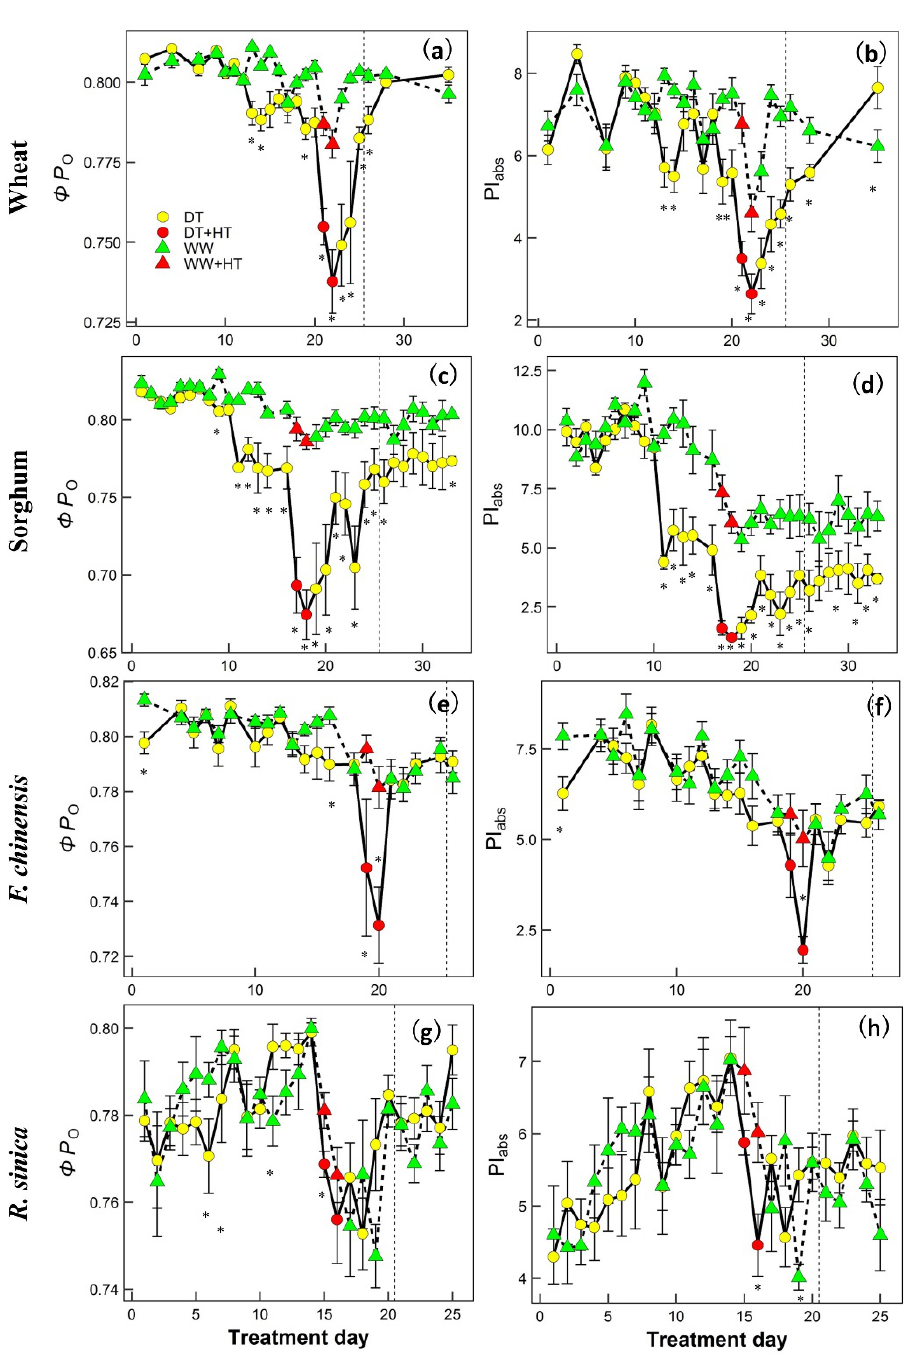
Figure 4. Time series responses of two representative chlorophyll fluorescence OJIP parameters: ABS/RC (absorption flux (Panels a , c , e , g )) and DI O /RC (dissipation flux (Panels b , d , f , h )) which were upregulated by drought and/or heat stress in wheat ( a , b ), sorghum ( c , d ), F. chinensis ( e , f ) and R. sinica ( g , h ). Plants were maintained under either drought (DT) or well-watered (WW) conditions and subjected to 2-day heat stress (HT) during the drought period. The dashed vertical line represents re-watering of the DT plants. Data show the mean ± S.E. of four replicates (n = 4). At each time point, ‘*’ indicates significant differences between the data for plants maintained under drought and well-watered conditions from one-way analysis of variance ( p < 0.05).